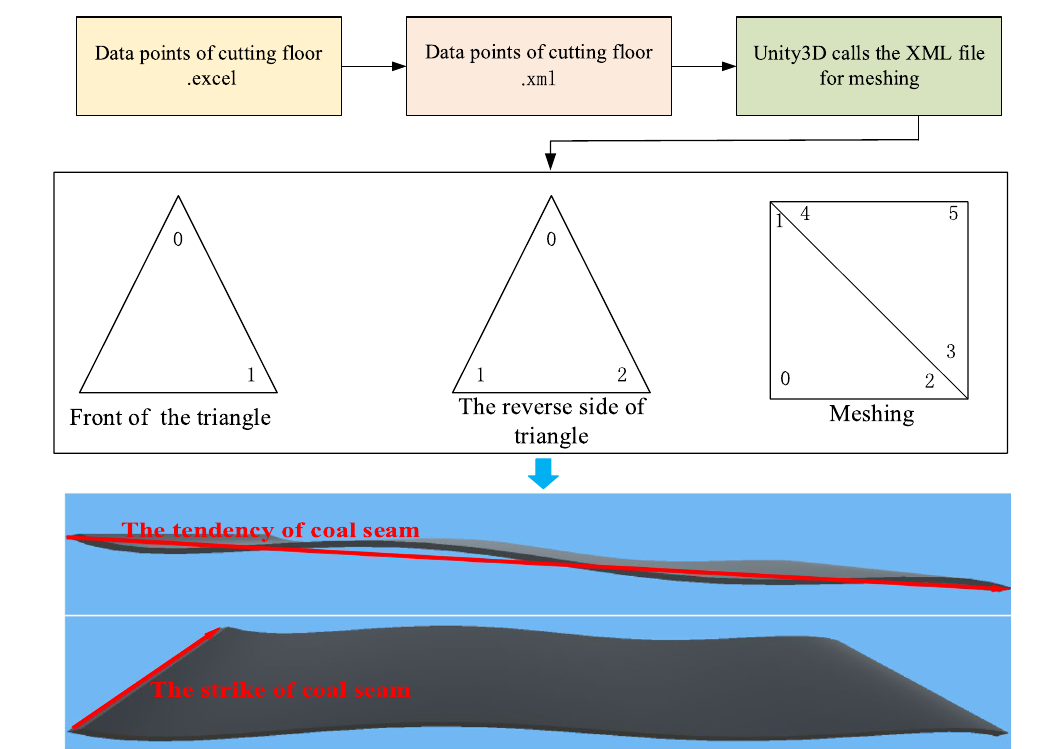
Fig. 8 Construction method for the coal seam cutting floor based on a mesh